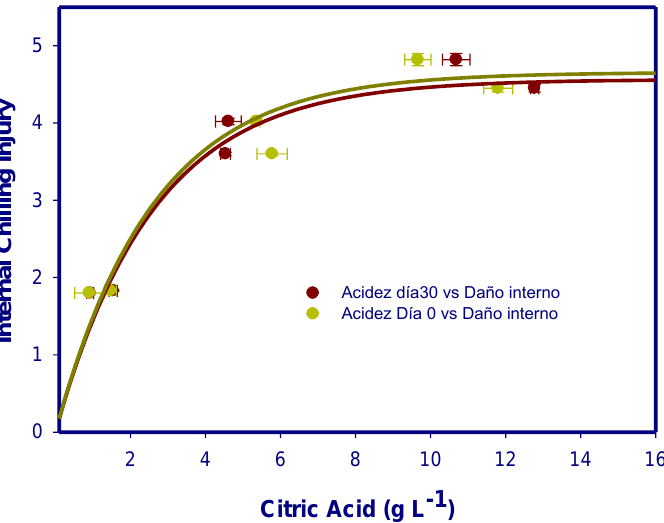
Figure 5. Nonlinear correlations between internal chilling injury on internal peel surface and citric acid concentration in juices at harvest (green circle) or and after storage (red circle). Data are the mean ± S.E. of determinations made in 3 replicates of 10 fruit.